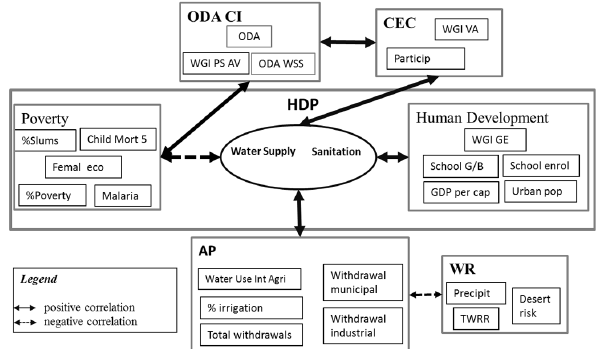
Fig. 1. Organisation and main correlations between selected vari-